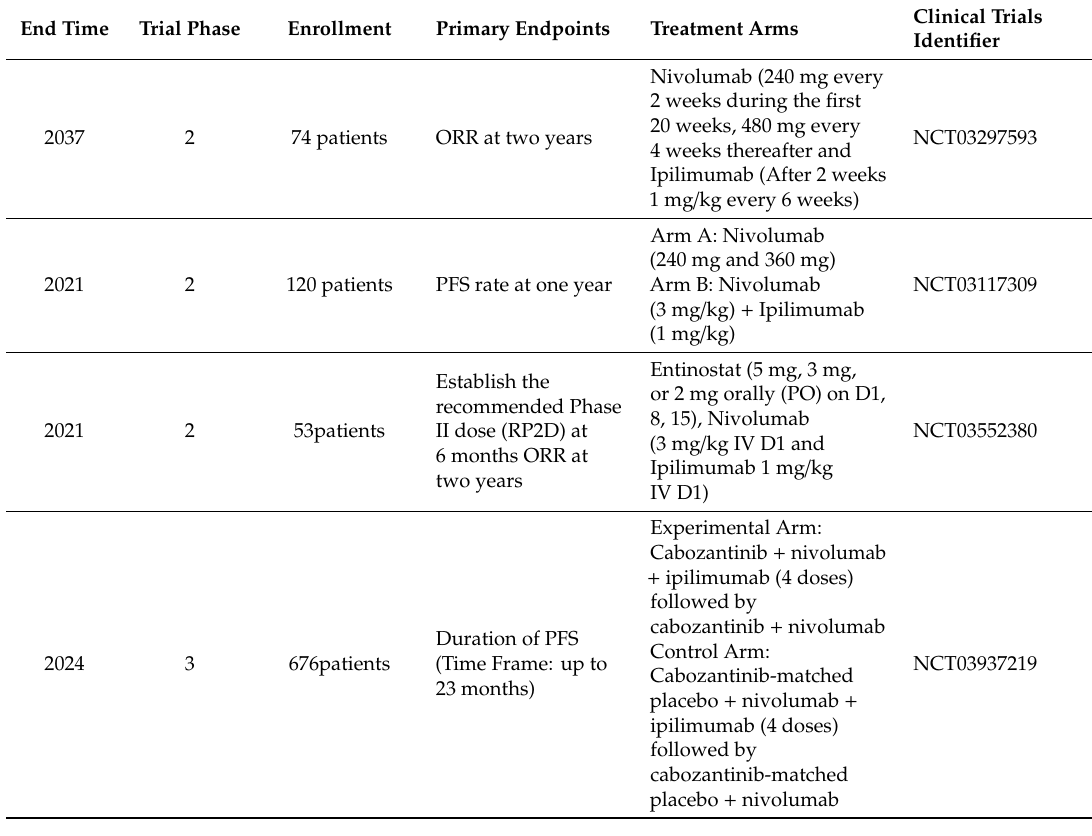
Table 2. (Until January 2020) clinical trials of ipilimumab plus nivolumab in